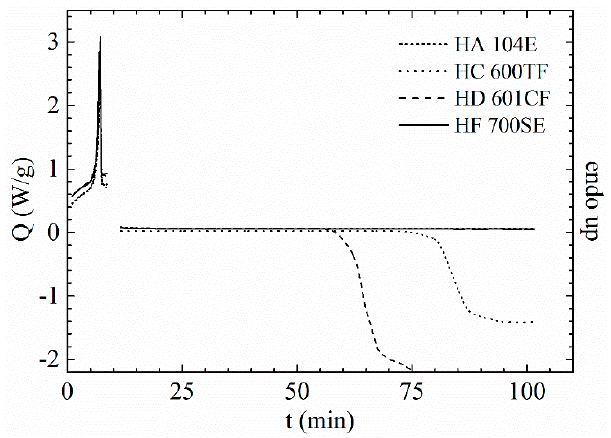
Figure 4. Comparison of the OIT of the shredded PP granules. Table 2. OIT before and after Soxhlet extraction of the PPs.